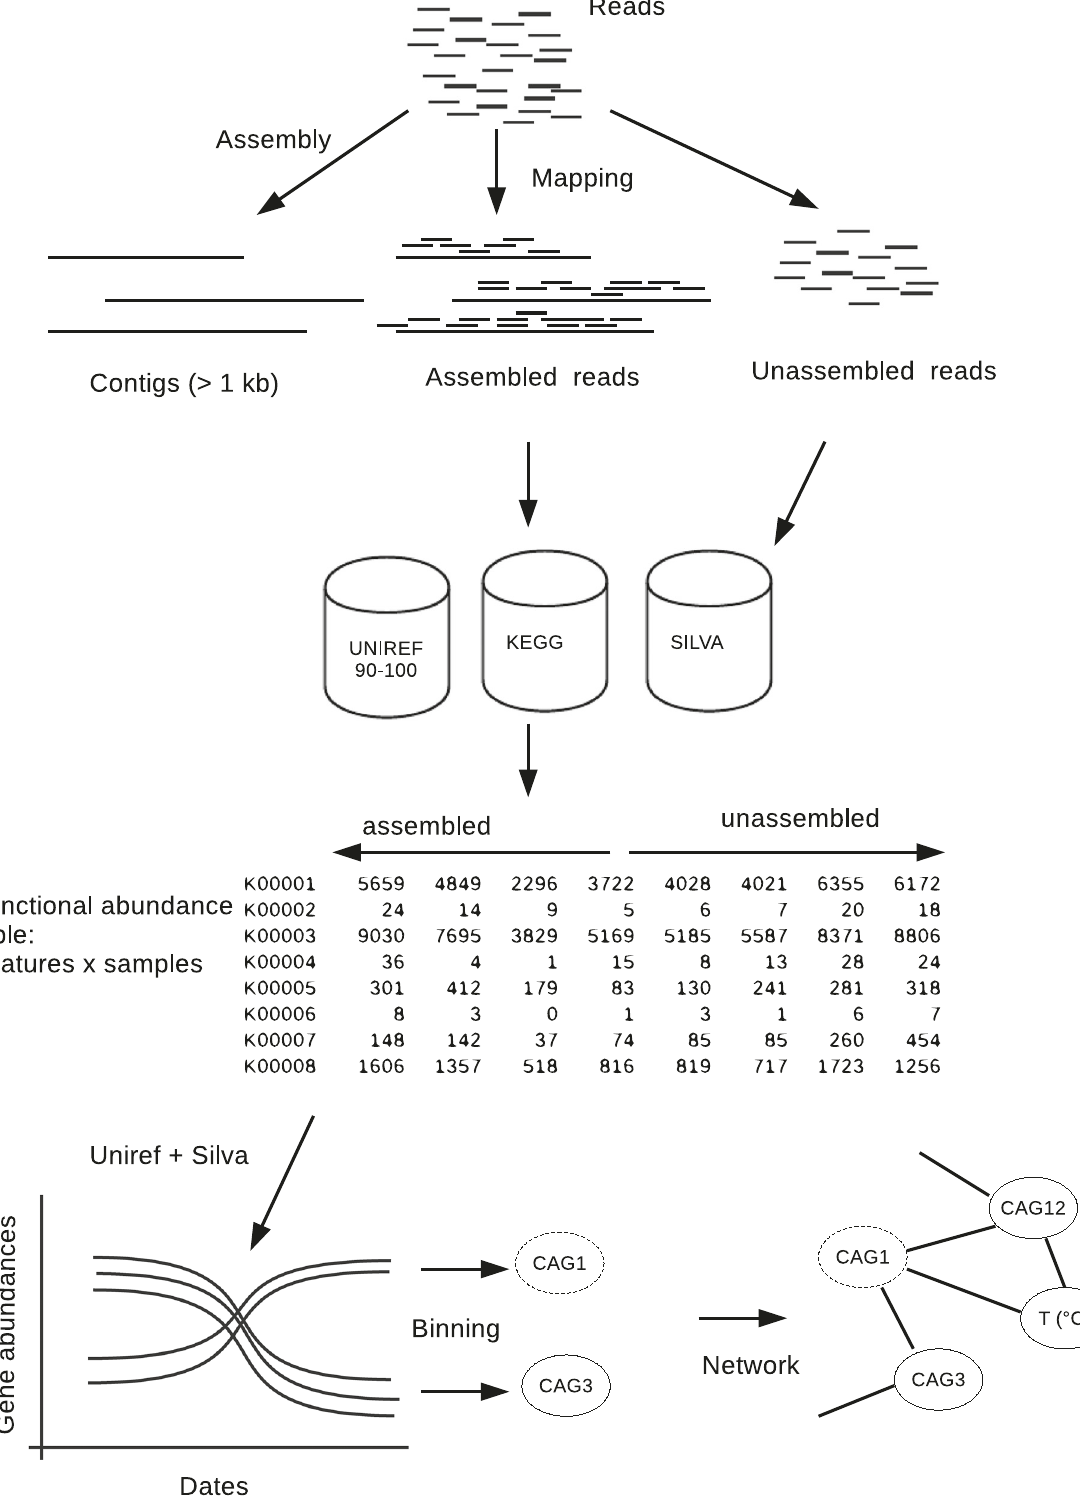
Fig. 1 Bioinformatics pipeline. Schematic showing the bioinformatic analysis conducted to separate assembled and unassembled reads from a 3-year metagenomic time series dataset. The reads were mapped against contigs and functional and OTUs tables were built with assembled and unassembled reads. From these tables Co-Abundance gene Groups (CAGs) were